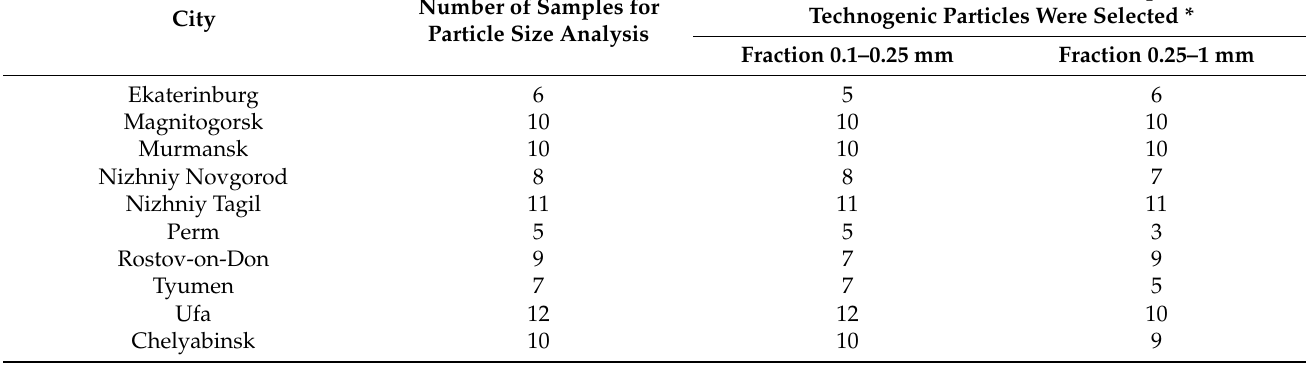
Table 2. The number of urban surface-deposited sediment (USDS) samples collected in the cities and analyzed for technogenic phase. Number of Obtained Particle Size Subsamples, in Which Number of Samples for Technogenic Particles Were Selected * City Particle Size Analysis Fraction 0.1–0.25